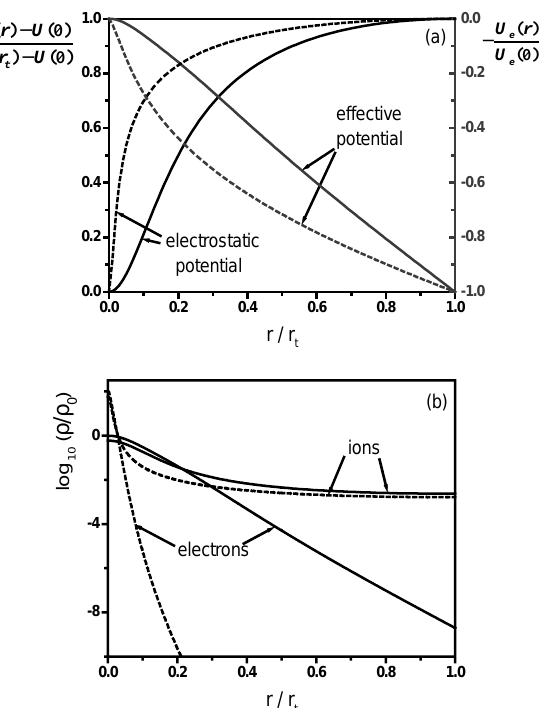
FIG. 2. Radial functions for (a) electrostatic and effective po- tentials and (b) space charge of electrons and ions, calculated for a 200 keV electron beam and neutralizing ions with a tempera- ture related to m i (cid:1) 4 . Full lines correspond to hotter ( m e (cid:1) 20 ) electrons and dashed lines to colder ( m e (cid:1) 31 )